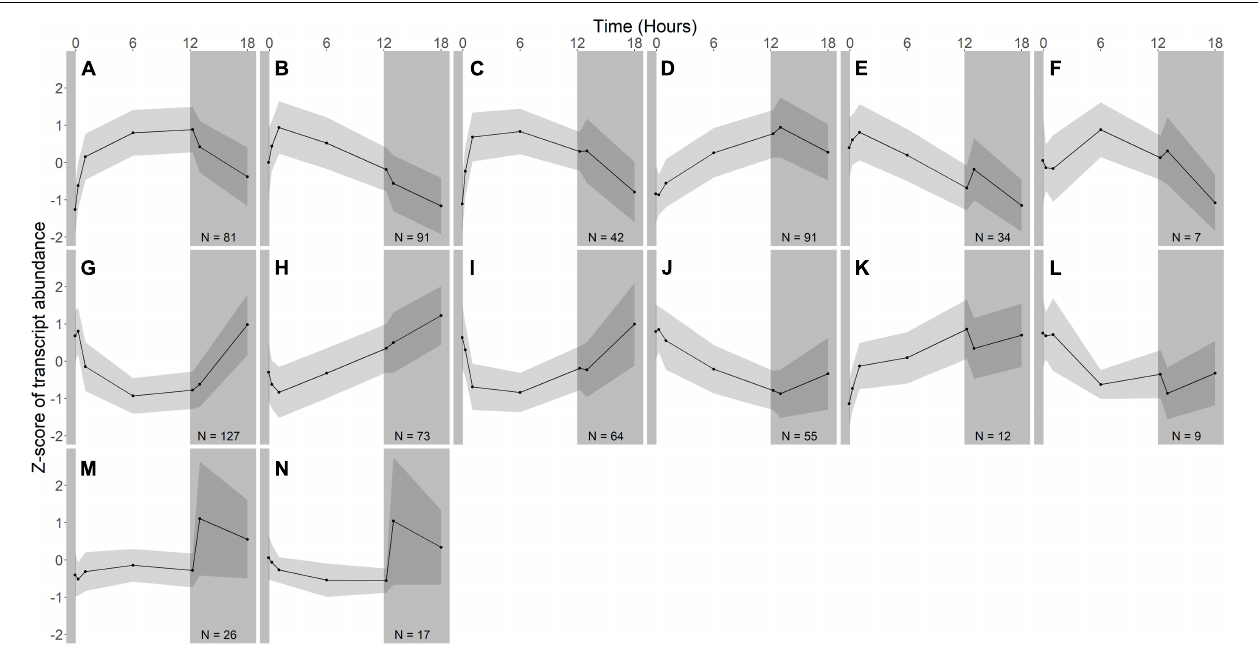
FIGURE 3 | Gene expression groups in R. lacicola . Groups of genes with similar expression patterns were identified using hierarchical clustering. Means of the z-scores for all genes are plotted, with one standard deviation indicated by the gray shading. N indicates number of genes in each group. (A–F) Groups of light-responsive genes whose expression increases in the light and decreases in the dark. (G–L) Groups of light-responsive genes whose expression decreases in the light and increases in the dark. (M,N) Groups of genes whose expression is consistent until the light turns off, then increases